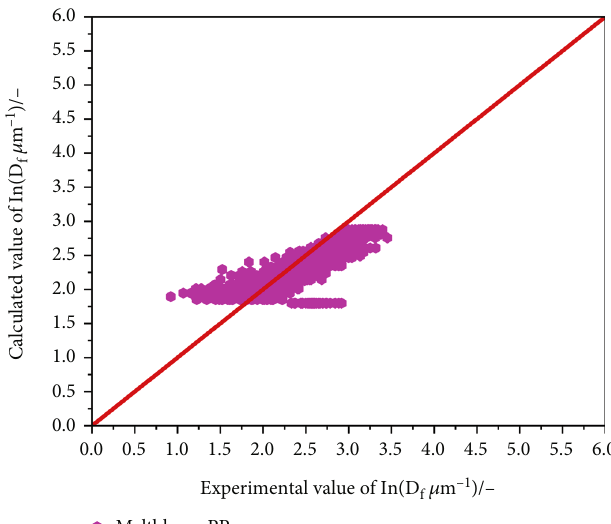
Figure 13: Comparison of the predicted and measured fi bre diameters on the melt blowing device using the fi xed output parameter with the new machine